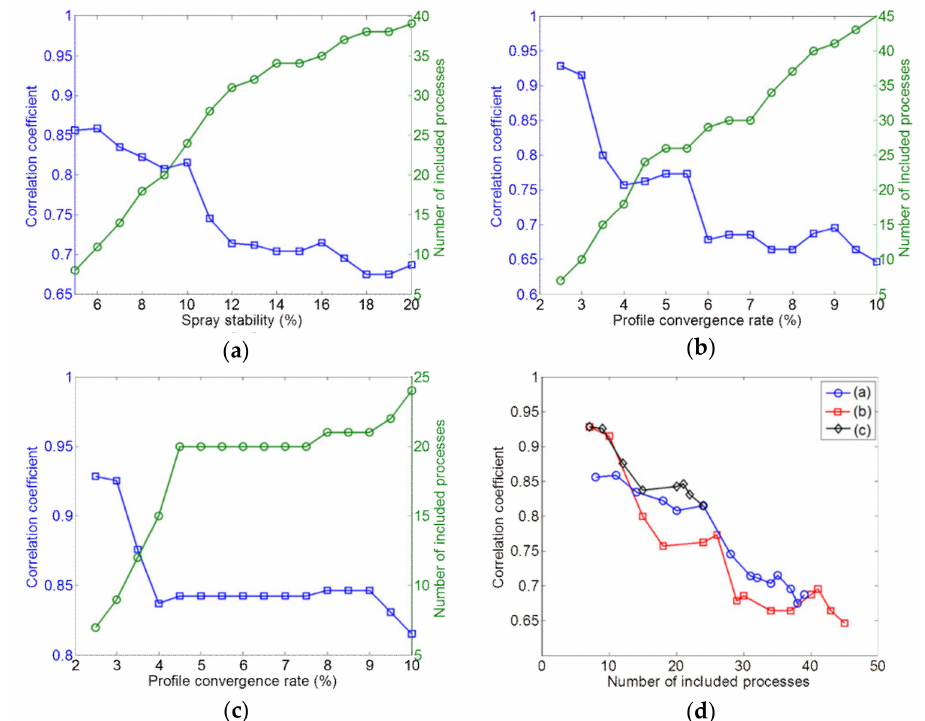
Figure 18. Changes in the correlation coe ffi cient and the number of process conditions that satisfied the selected criteria for the stability ( a ) and the profile convergence ( b ) as the selectred criteria is gradually increased; ( c ) relationship between the profile convergence and the correlation coe ffi cient when the stability of spray patterns is limited to the criteria of 10%; ( d ) change of the correlation coe ffi cient depending on the number of included processes in ( a – c